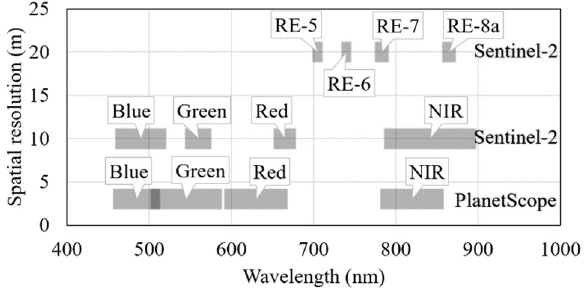
Figure 2. Overview of the Sentinel-2 and PlanetScope spectral bands used in this research